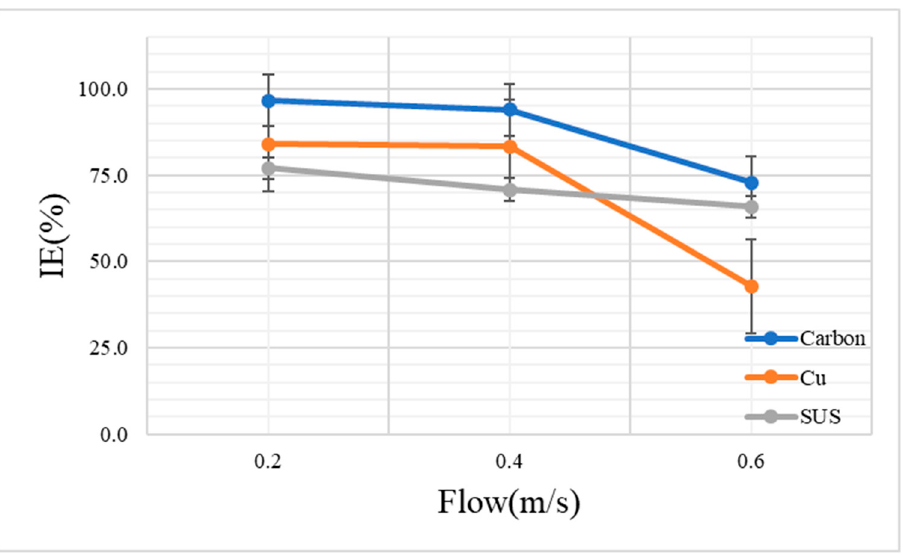
Figure 4. Inactivation efficiency (%) of the aerosolized MS2 bacteriophages for each material and flow velocity.